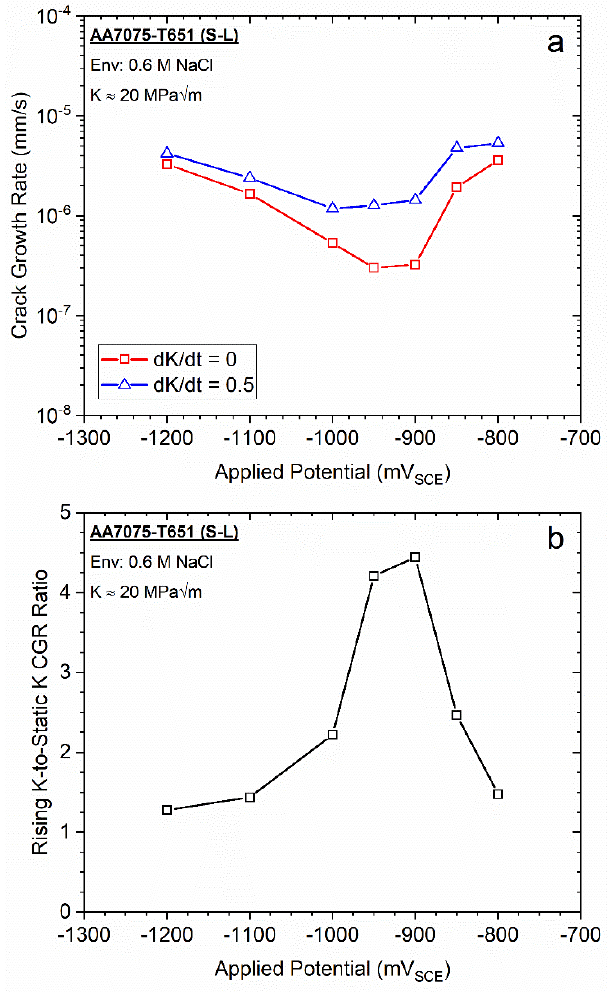
Figure 2. ( a ) Measured crack growth rate versus applied potential relationships for AA7075-T651 immersed in 0.6 M NaCl at K = 20 MPa √ m under static K and fixed dK/dt (0.5 MPa √ m/h) loading conditions. The ratio of the measured crack growth rates for the two testing approaches as a function of applied potential are shown in ( b ).